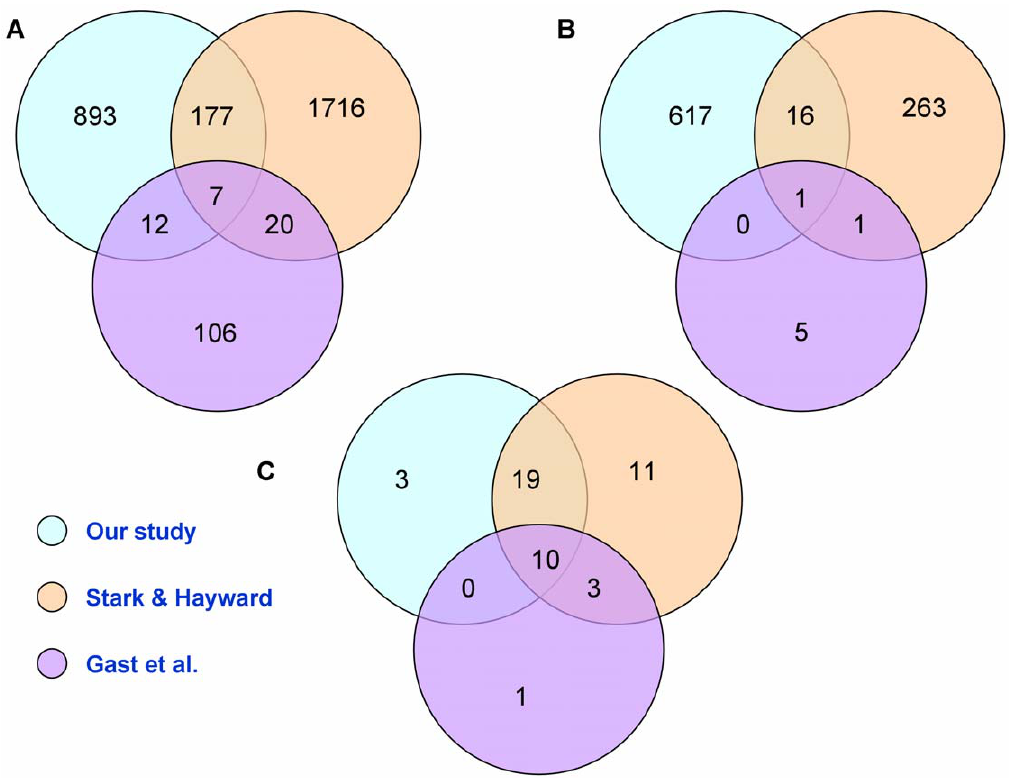
Figure 4. Intersection between our dataset and two published datasets of SCNA-genes and derived pathways. A. Intersection between amplified genes in published melanoma datasets (Stark and Hayward 2007; Gast et al., 2010) and our list of over-expressed genes within focal amplifications B. Intersection between genes within homozygous deletions from the Stark and Hayward and Gast et al. datasets and our list of non-expressed genes within deletions C. Intersection between pathways found significantly affected by SCNAs from our analysis of the three datasets.